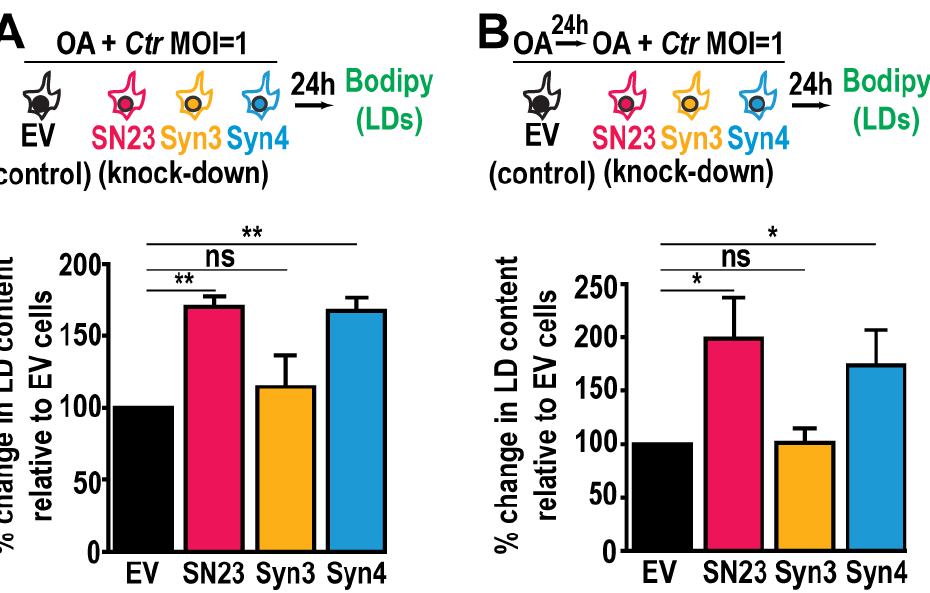
FIGURE 4. The addition of OA enhances the induction of LD content in SNAP-23 or Syntaxin 4 knock down cells during Chlamydia infec- tion. Cells were ( A ) infected in the presence of OA for 24 h, or ( B ) pre-treated with OA for 24 h before infection. The cells were then stained with BODIPY, fixed, and the BODIPY intensity was measured by flow cytometry. For the infected populations, only the mCherry-positive cells were measured. Graphs represent the average increase in BODIPY staining following infection relative to empty vector control cells from at least three independent experiments ± the standard deviation. The percent increase in BODIPY staining following infection for the empty vector control cell line was arbitrarily set at 100% and represents ( A ) 174.72% ± 17.61% and ( B ) 181.63% ± 30.55%. Values for the KD cells were then normalized to the EV control. Asterisk (*) denotes a p value < 0.05 and (**) denotes a p value <0.01. ns = not significant. EV = empty vector control, SN23 = SNAP-23, Syn3 = Syntaxin 3, Syn4 = Syntaxin 4, LDs = lipid droplets. MOI = multiplicity of infection. Ctr = Chlamydia trachomatis